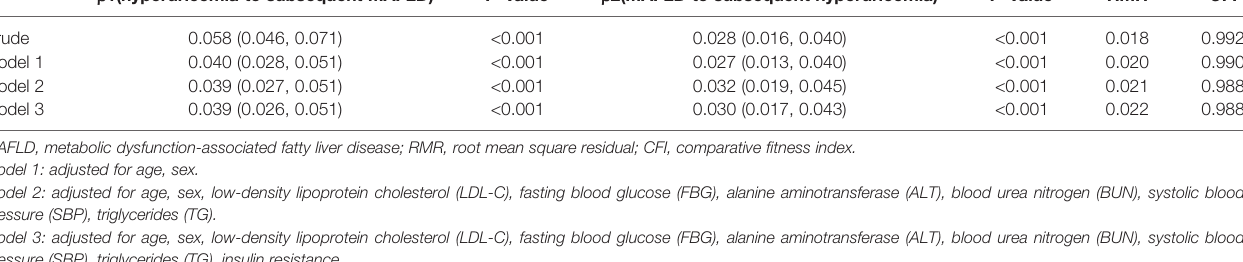
TABLE 4 | The cross-lagged path analysis for the temporal association between hyperuricemia and MAFLD. b 1(hyperuricemia to subsequent MAFLD)